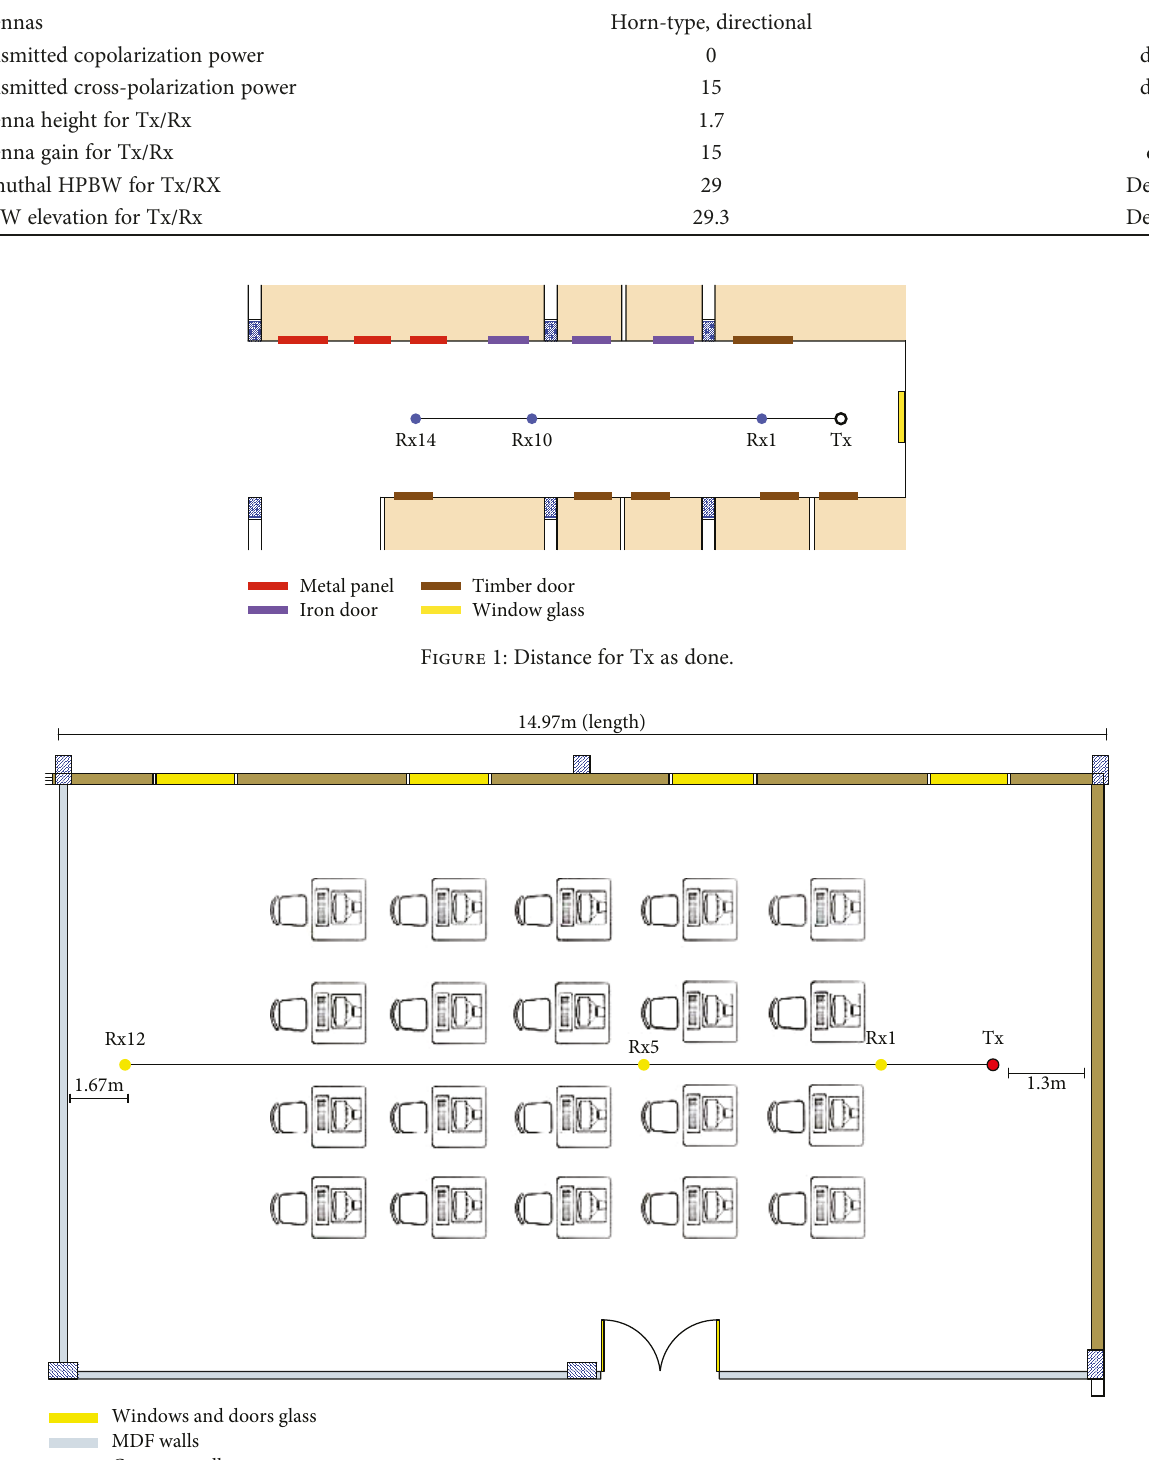
Figure 2: The computer room ’ s